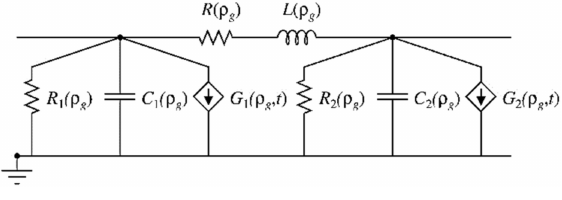
Figure 4. Pi-circuit